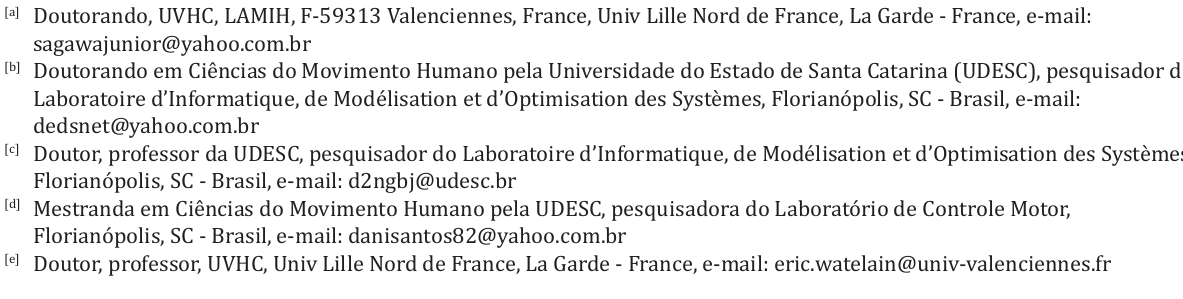
Objetivos : Analisar aspectos relacionados à propulsão em cadeira de rodas. Materiais e métodos : Para o delineamento desta revisão, foi realizada uma busca em bases de dados eletrônicas a partir das seguintes palavras-chave: wheelchair propulsion , wheelchair biomechanics e wheelchair uses . Foram selecionados ar- tigos completos nas línguas francesa e inglesa. Resultados : A propulsão em cadeira de rodas é um movi- mento complexo que requer a execução de repetidas aplicações de força durante curto período de tempo. Nesse movimento são exigidos altos níveis de força em razão do baixo rendimento mecânico da cadeira. Pôde ser caracterizado que os cadeirantes não estão satisfeitos com suas cadeiras, os locais não estão adap- tados à sua presença e faltam critérios específicos para o ajuste desse importante equipamento. Os